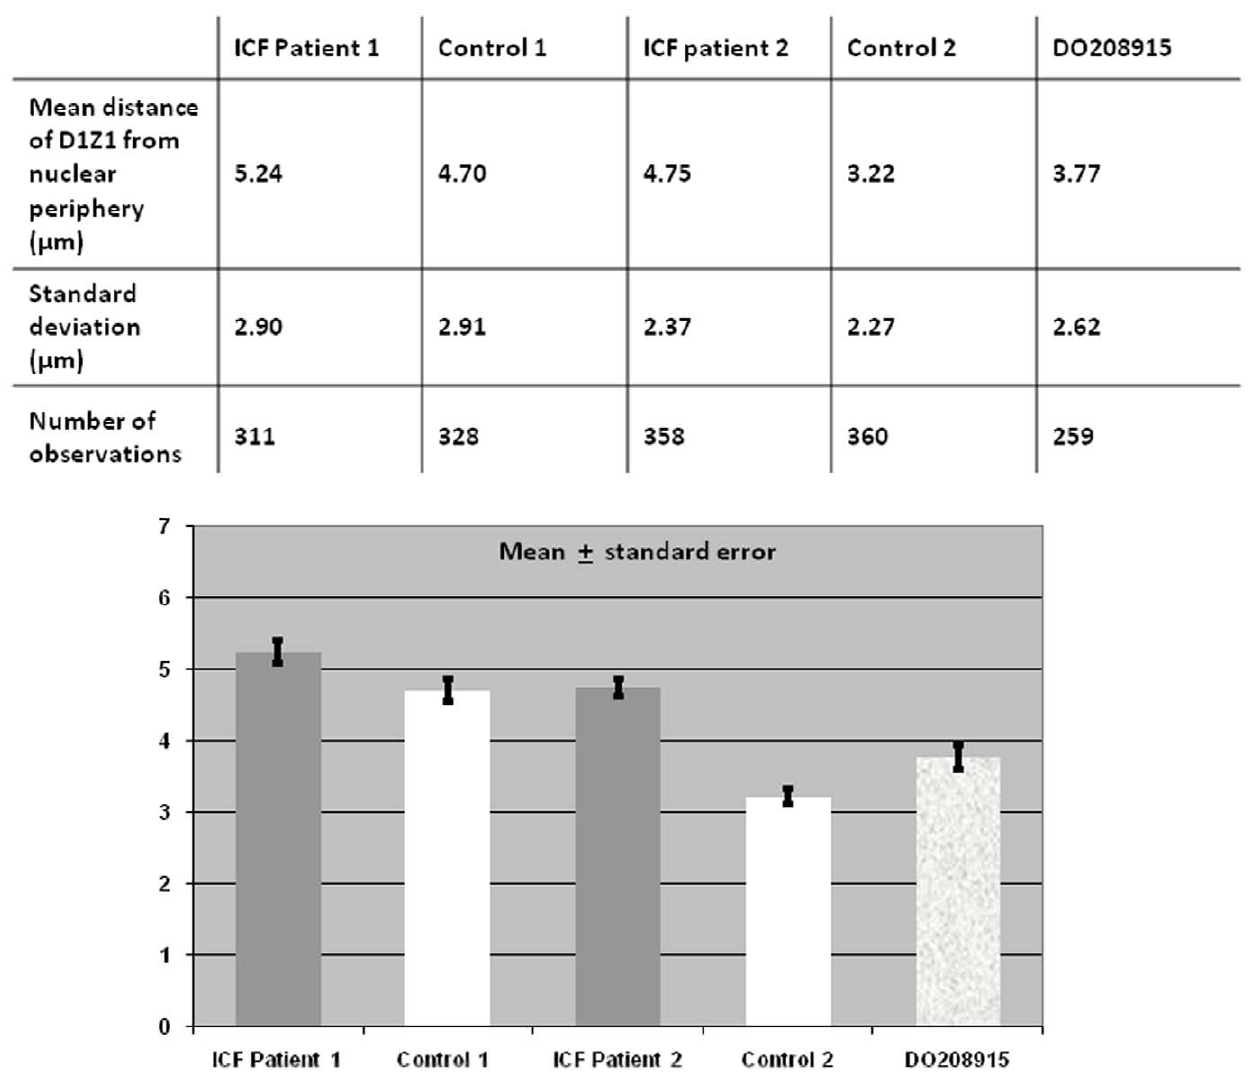
Figure 7. Chromosome 1 juxtacentromeric heterochromatin positioning in relation to the extreme nuclear periphery: distance measurements in ICF cells and controls. The average distance between the centroid of the chromosome 1 juxtacentromeric heterochromatic signal and the extreme nuclear periphery, as defined by the edge of the DAPI nuclear staining, was calculated in unsynchronised B-lymphoblastoid cells from ICF Patients 1 and 2, Controls 1 and 2 and DO208915. When performing a Kolmogorov-Smirnov test, the distance of chromosome 1 juxtacentromeric heterochromatin from the nuclear periphery is significantly greater in ICF cell lines when compared to control cell lines (D=0.1405, P ,